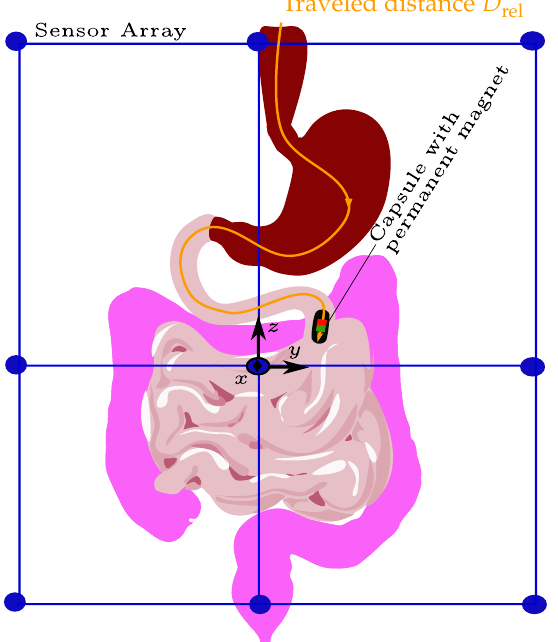
Figure 1. Schematic of the system design using the differential method to track the traveled distance of a capsule endoscope within the gastrointestinal tract.